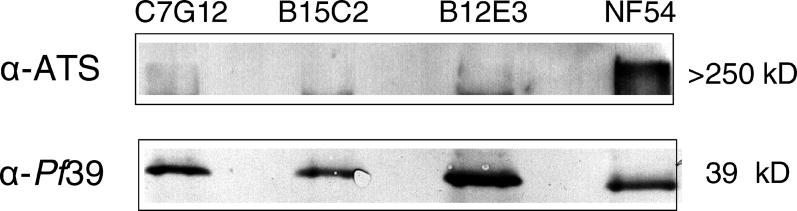
PfEMP1 Is Not Expressed in the Knock-Out Transgenic LinesWestern blot analysis of whole cell extracts isolated from NF54 and the three transgenic lines B12E3, B15C2, and C7G12 growing under blasticidin pressure. Extract were probed with antibodies to either the conserved C terminus of PfEMP1 (α-ATS) or to the ER protein Pf39 (α Pf39). α-ATS signal appears only in NF45 parasites and not in any of the transgenic lines.